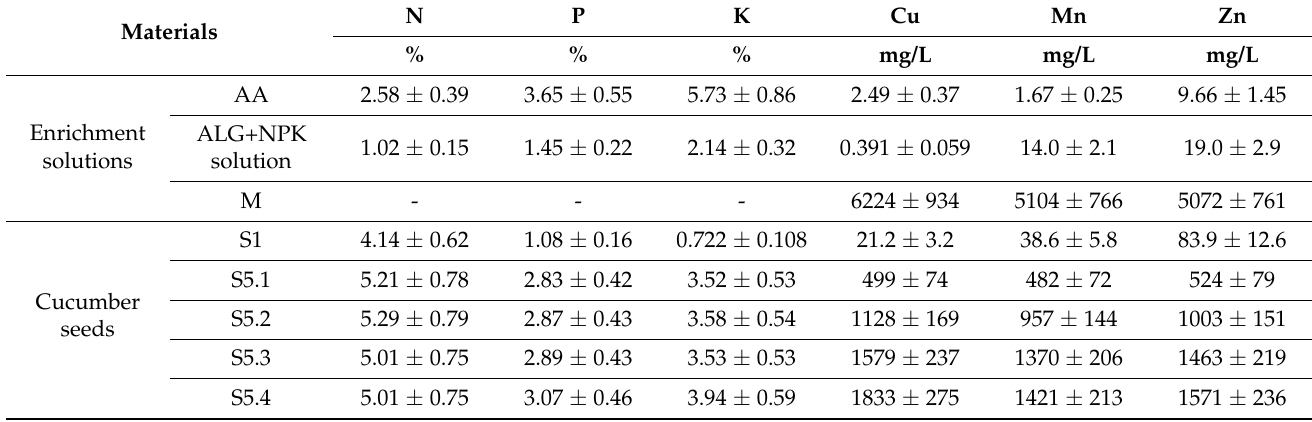
Table 7. Macro and micronutrient levels in enrichment media and coated seeds (M—micronutrient solution, ALG— alginate, S1—Uncoated seeds, S5.1—Seed coating containing a solution of 2% alginate with amino acids (37.6 mL/100 g), micronutrients (37.5 mL/100 g), and NPK, S5.2—Seed coating containing a solution of 2% alginate with amino